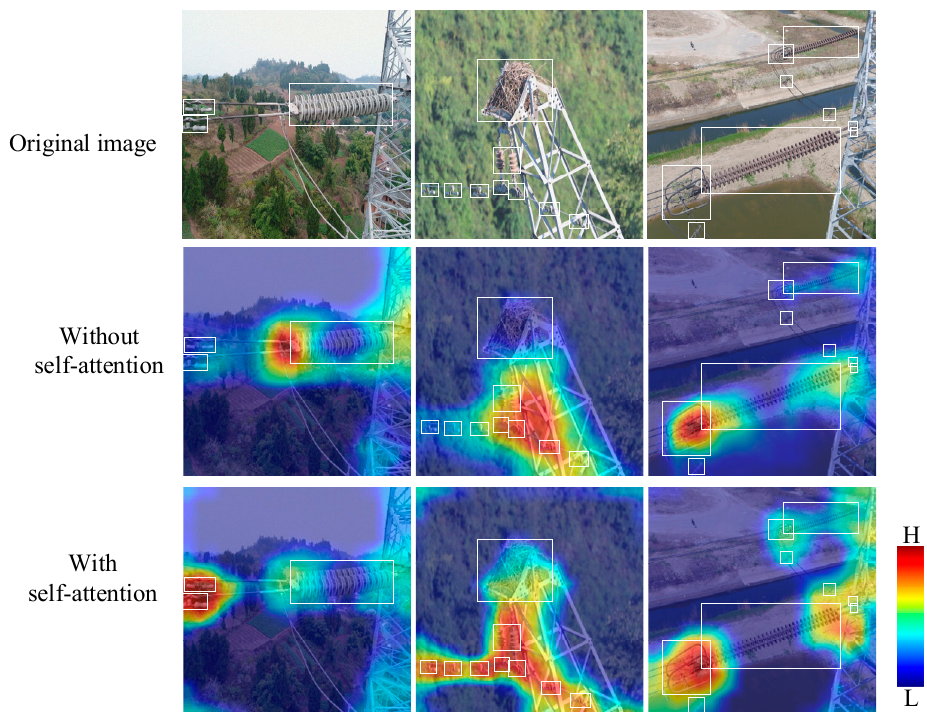
Figure 6. Heatmap